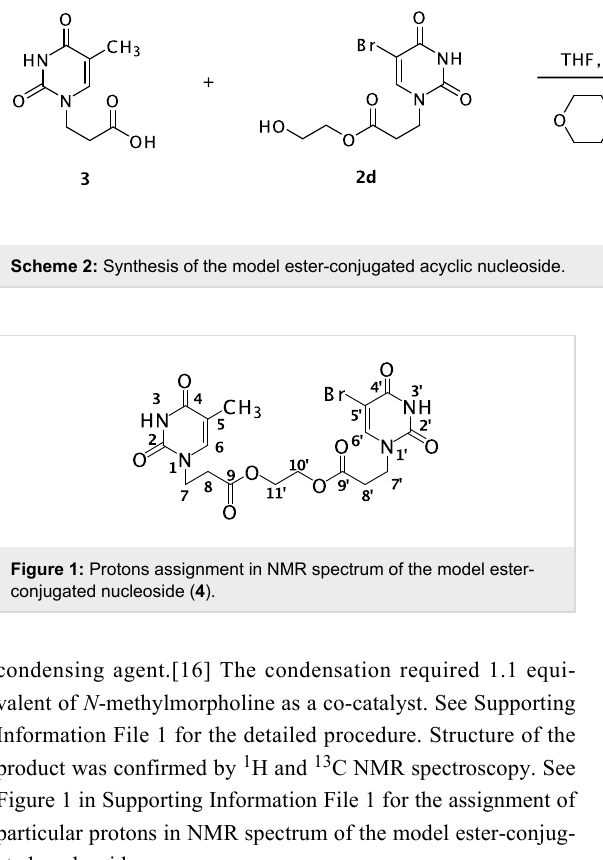
condensing agent.[16] The condensation required 1.1 equi- valent of N -methylmorpholine as a co-catalyst. See Supporting Information File 1 for the detailed procedure. Structure of the product was confirmed by 1 H and 13 C NMR spectroscopy. See Figure 1 in Supporting Information File 1 for the assignment of particular protons in NMR spectrum of the model ester-conjug- ated